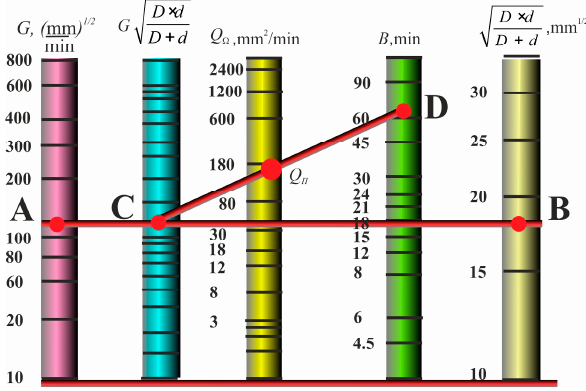
Figure 10. Nomogram for determining the performance of the grinding process with fine-grained wheels.